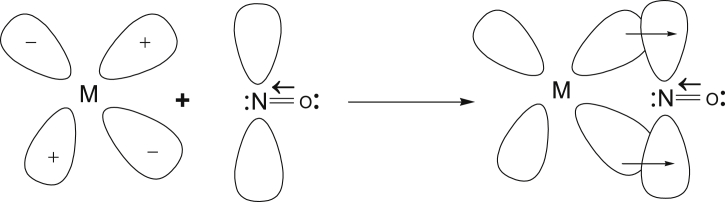
Formation Pie bond.